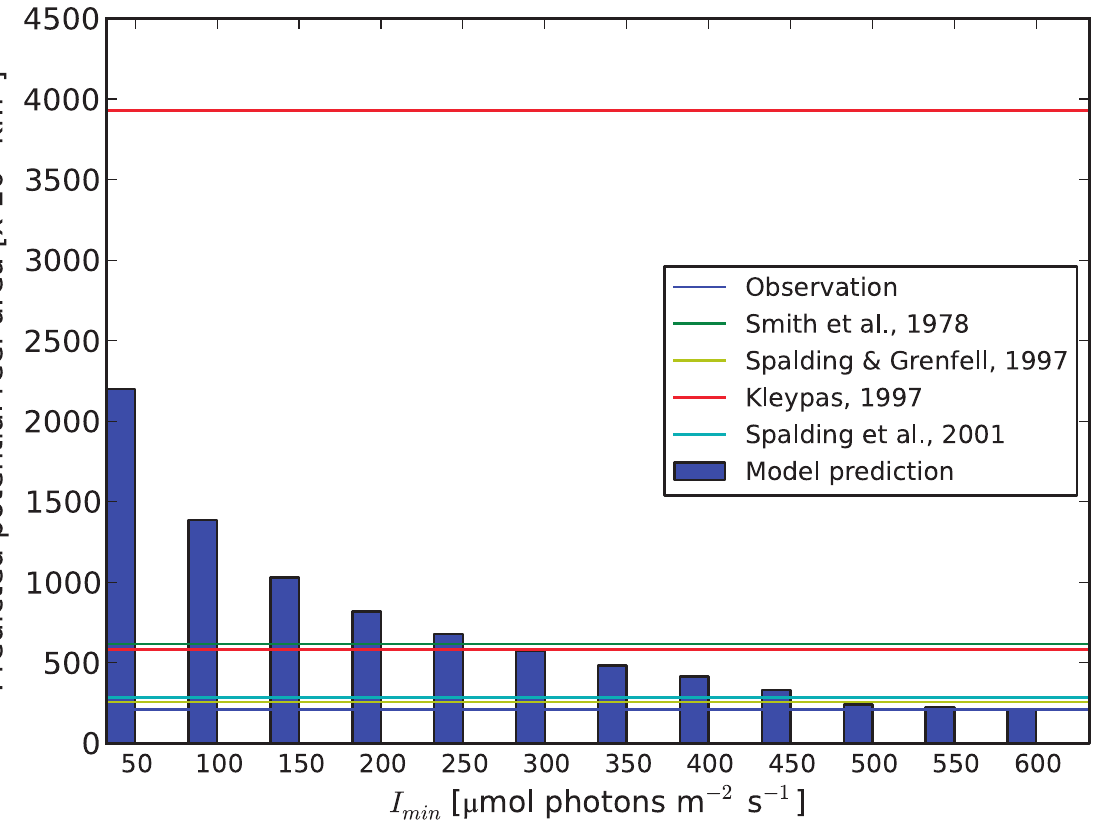
Fig 6. Area of potential reef habitats at different I min values. The blue line represents the observed area covered by reefs; the green line represents the reef area estimated by Smith (1978), the yellow line represents the reef area estimated by Spalding & Grenfell (1997), the red line represents the potential reef habitat area estimated by Kleypas (1997), and the light blue line represents the potential reef habitat area estimated by Spalding et al.